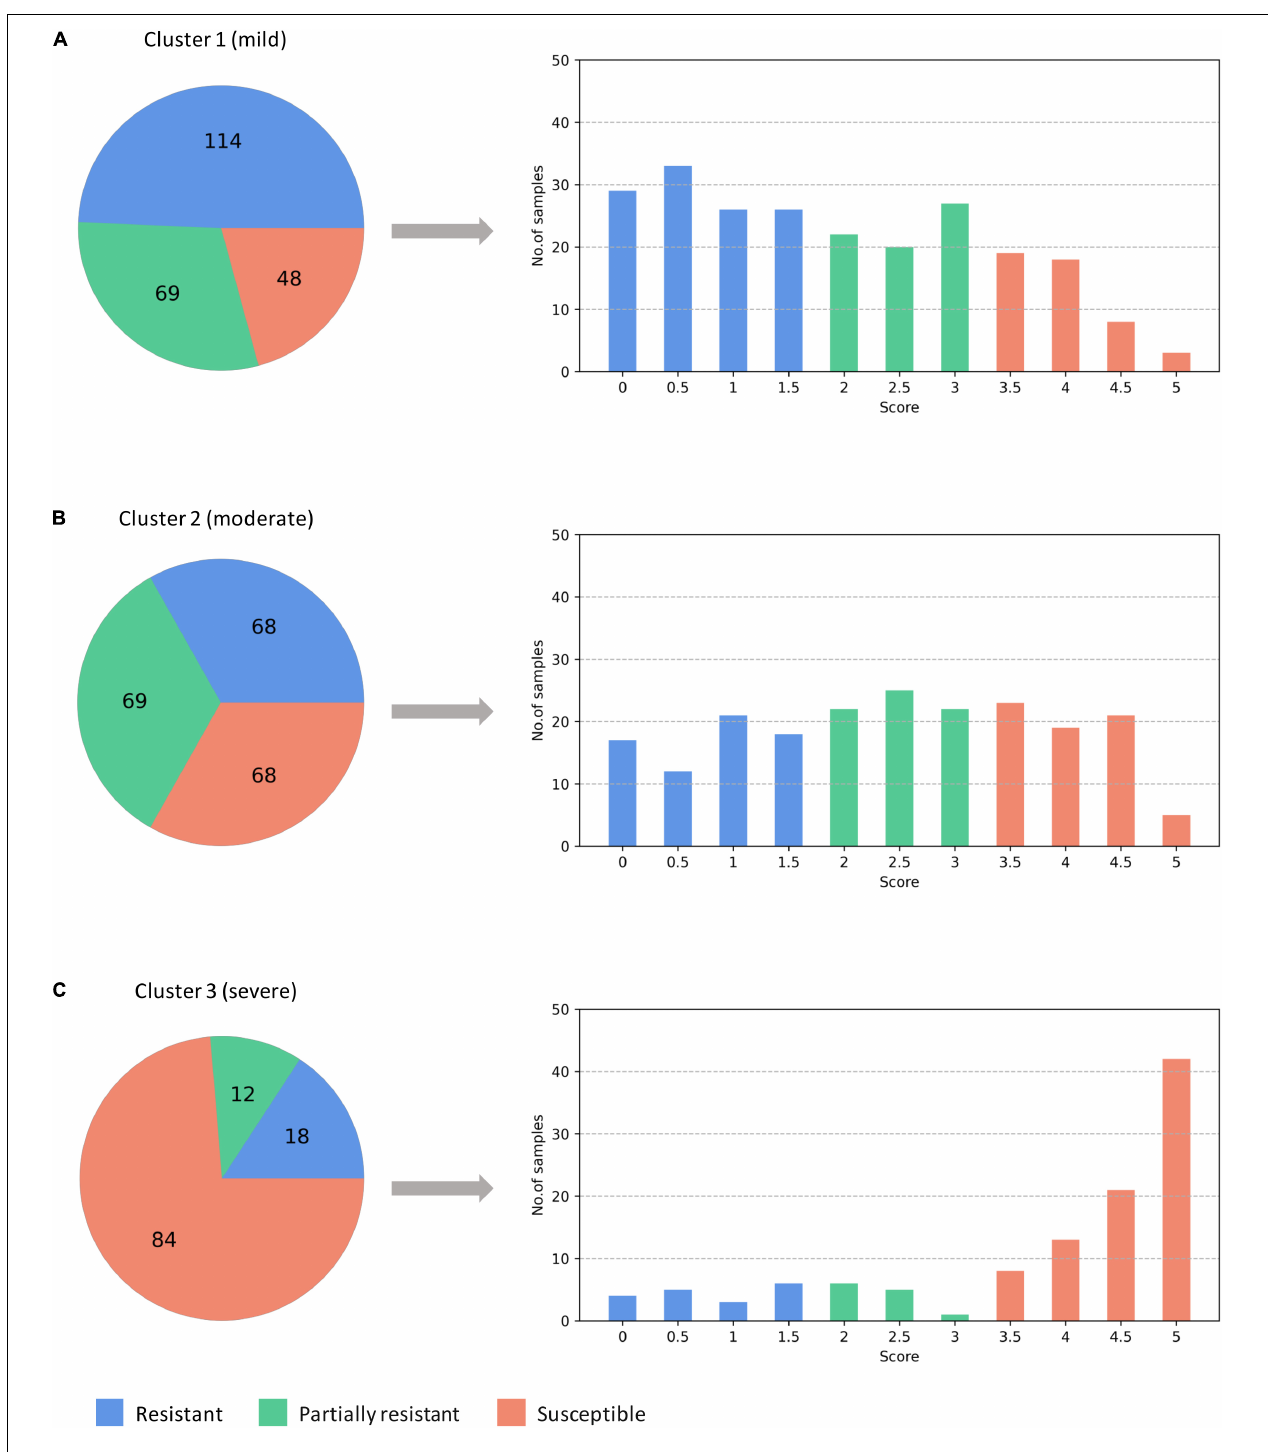
FIGURE 11 | The predicted three subtypes of ARR: (A) mild; (B) moderate; (C) severe. The numbers denote how many samples are assigned to one of the subtypes. ARR, Aphanomyces Root Rot.